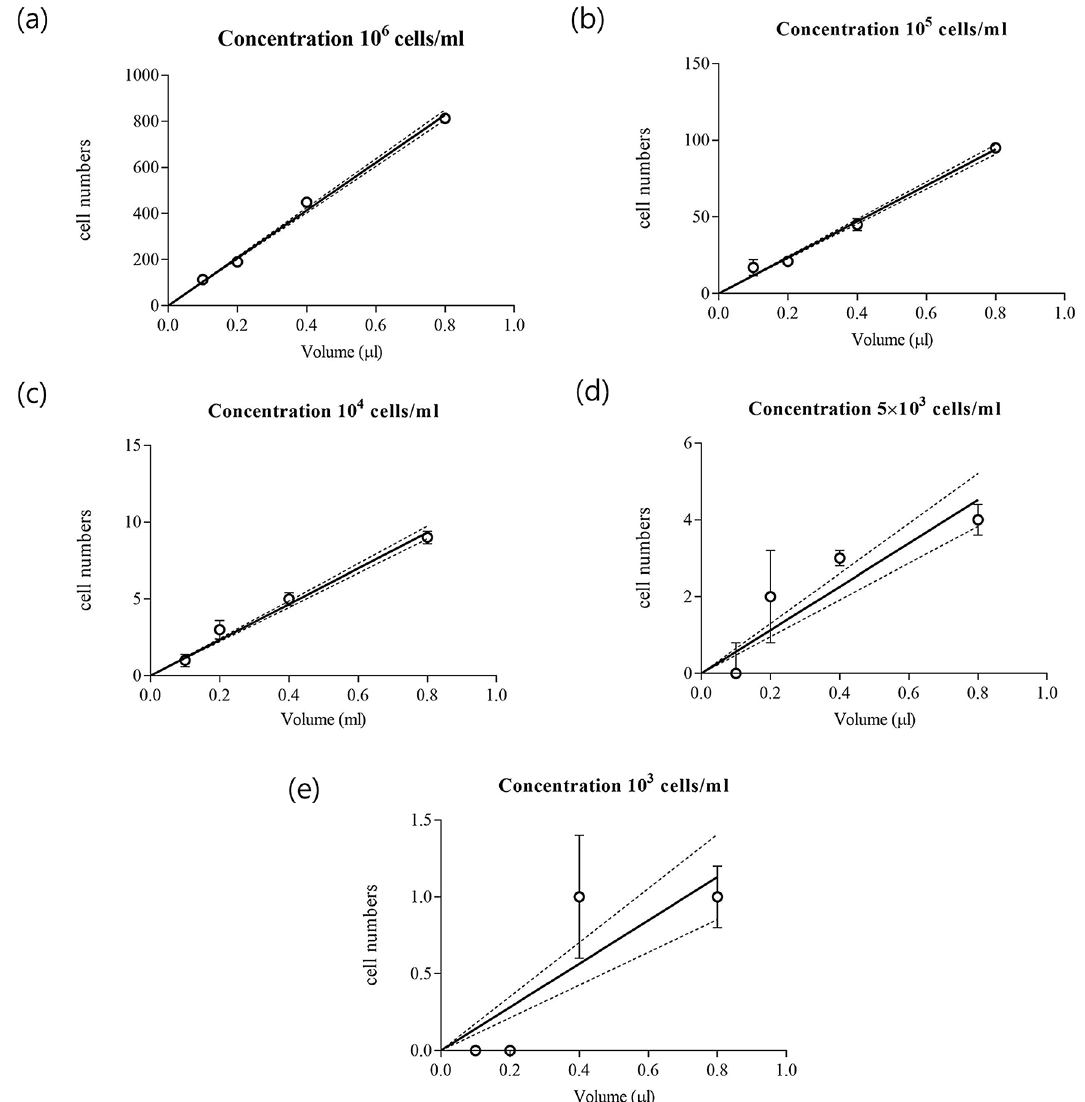
Figure 3. The cell numbers according to chamber volume in different cell concentration. ( a ) 10 6 cells/ml, ( b ) 10 5 cells/ml, ( c ) 10 4 cells/ml, ( d ) 5 × 10 3 cells/ml, and ( e ) 10 3 cells/ml. Each point is the average of cell